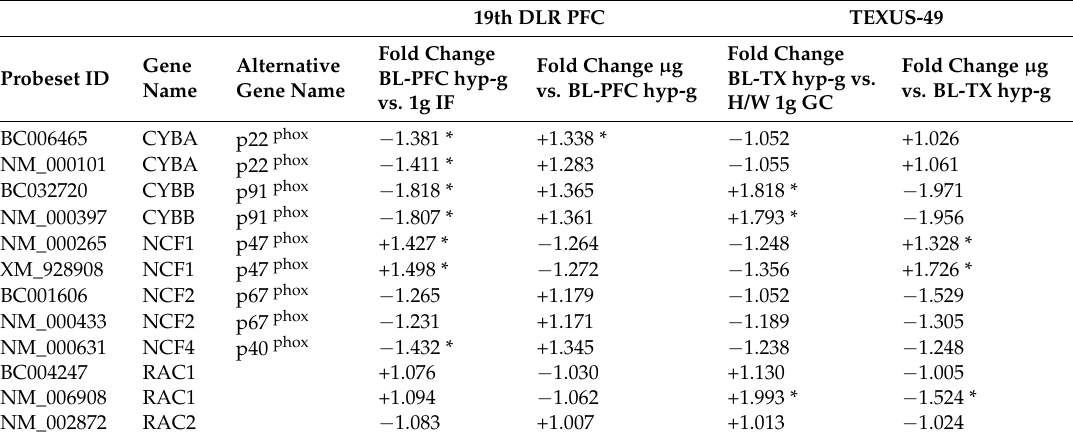
Table 11. Transcripts belonging to genes coding for nicotinamide adenine dinucleotide phosphate (NADPH) oxidase subunits. Plus values with asterix (*): significantly up-regulated transcripts ( p -value < 0.05, fold change (FC) ≥ 1.3), minus values with asterix (*): significantly down-regulated transcripts ( p -value < 0.05, FC ≤ − 1.3). For the abbreviations of the experiment group names see Table